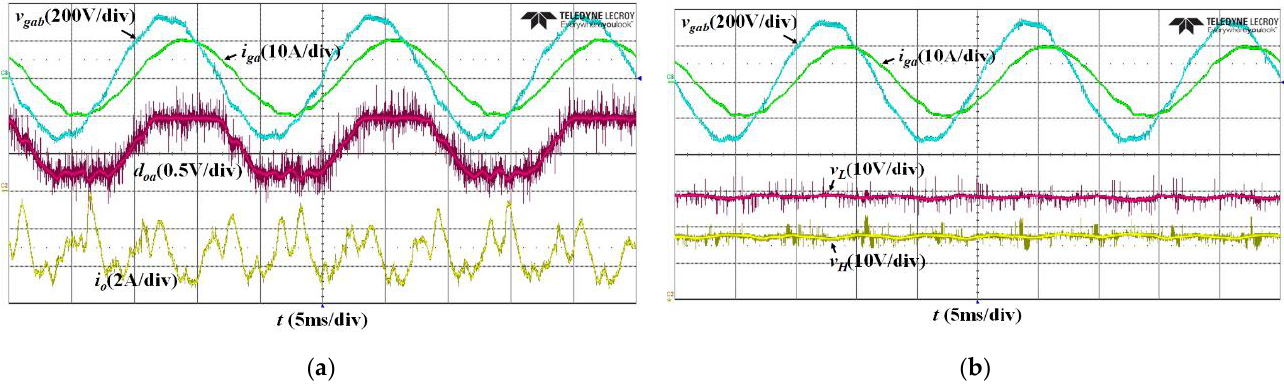
Figure 11. Experimental waveforms under unbalanced load condition corresponding to 45% deviation of output power. ( a ) v gab : grid line-to-line voltage; i ga : grid current; d oa : final duty; i o : averaged neutral point current. ( b ) v gab : grid line-to-line voltage; i ga : grid current; v H , v L : DC-link voltage.